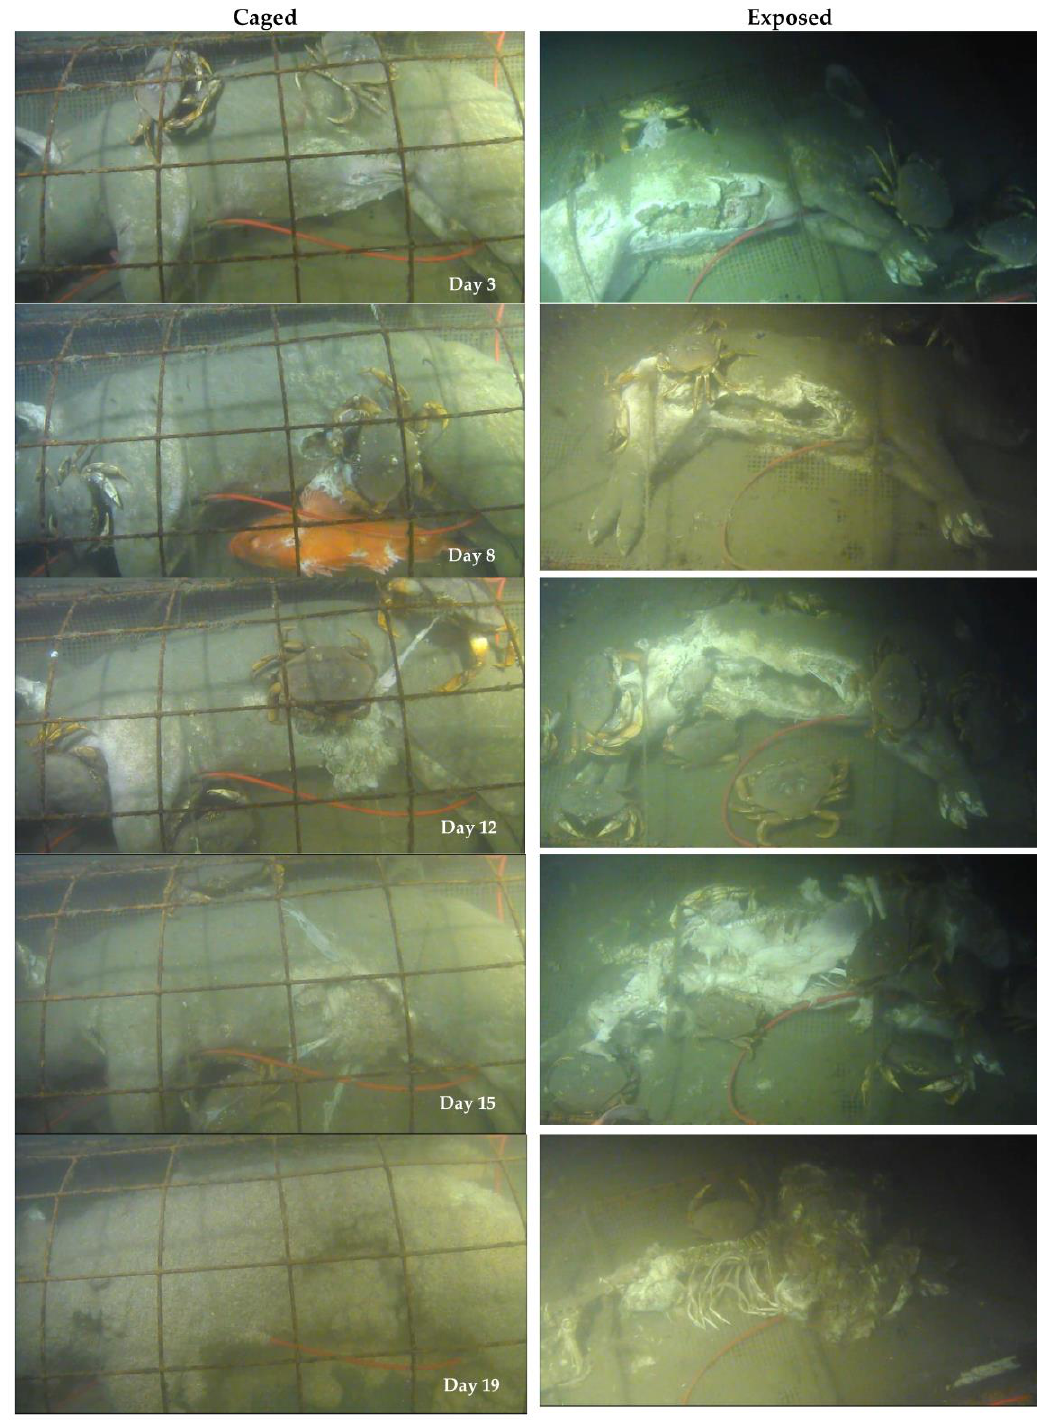
Figure 3. Faunal scavenging of caged and exposed carcasses in fall at 170 m in the Strait of Georgia (Ocean Network Canada’s VENUS observatory).